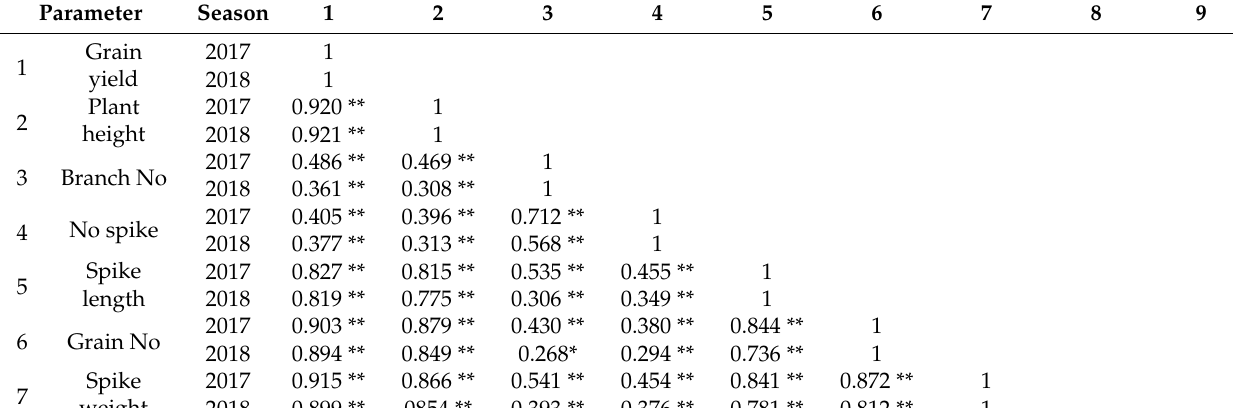
Table 8. A matrix of simple correlation coefficients between grain yield and other important traits estimated for 2017 and 2018